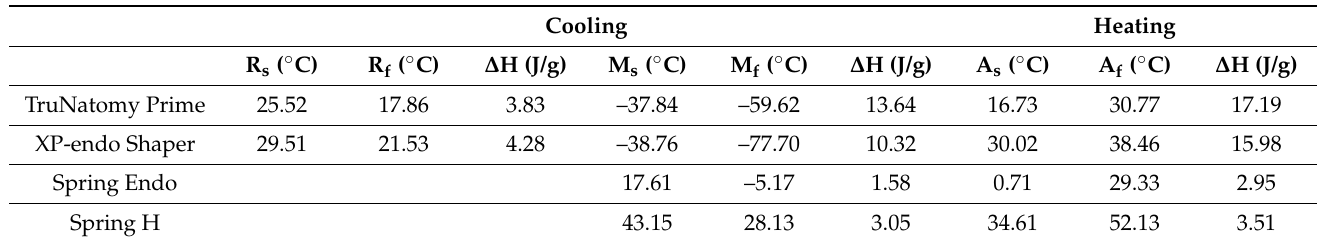
Table 5. Transformation temperatures and associated energy from the differential scanning calorime- try